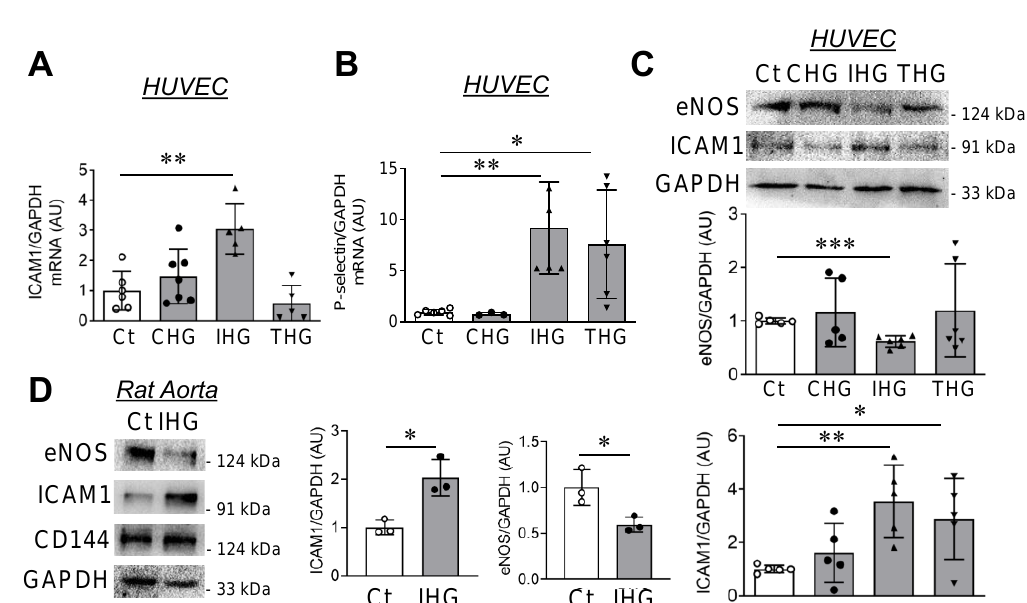
Figure 1. Intermittent hyperglycemia triggers an inflammatory state of endothelial cells. ( A , B ) Transcriptomic analysis of ICAM1 (( A ), n = 5) and P-selectin ( B ), n = 4–6) in HUVEC exposed to differential high glucose treatment conditions; control, constant (72 h high glucose, 25 mM), intermittent (alternating 5.5 mM and 25 mM cycle of 12 h for 3 cycles), and transient (24 h high glucose, 25 mM, followed by 48 h of normal glucose, 5.5 mM). ( C ) Immunoblotting and quantitation for eNOS and ICAM1 in HUVEC challenged with previously mentioned high glucose treatment conditions ( n = 5–6). ( D ) Immunoblotting and quantitation of eNOS, ICAM1, and CD144 in tissue lysates of rat aortic rings (2 mm length) that were exposed to intermittent high glucose ( n = 3). Control treatment condition (cells constantly exposed to normal glucose (5.5 mM)) represented as “Ct” in the figure. All analyzed data were normalized to the control treatment condition. Values represent the mean ± SD. * p < 0.05, ** p < 0.01 and *** p < 0.001 by one-way ANOVA analysis or by unpaired t test.